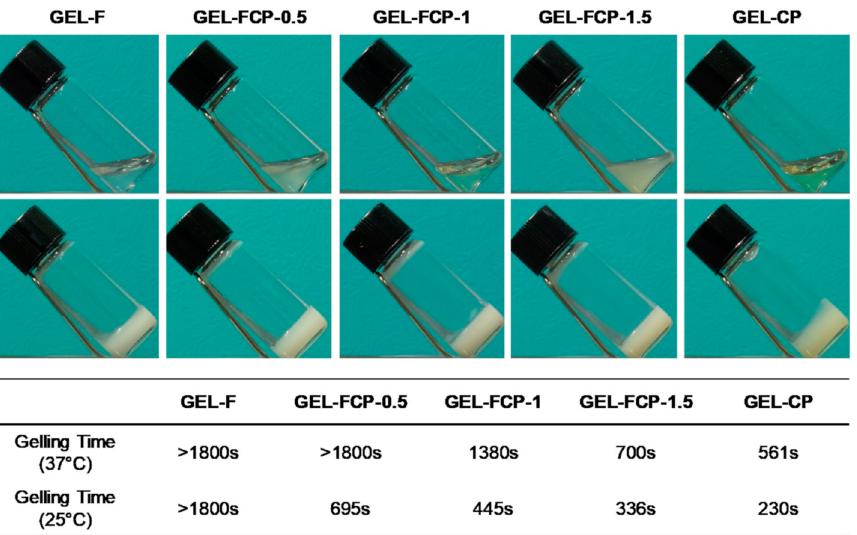
Figure 2. Photographs for the formation of a supramolecular hydrogel (in the mixed system be- tween CS-mPEG and F127) of CS-mPEG/F127 and 7.0 wt% (in the mixed system) of α -CD at room temperature (25 ◦ C) and body temperature (37 ◦